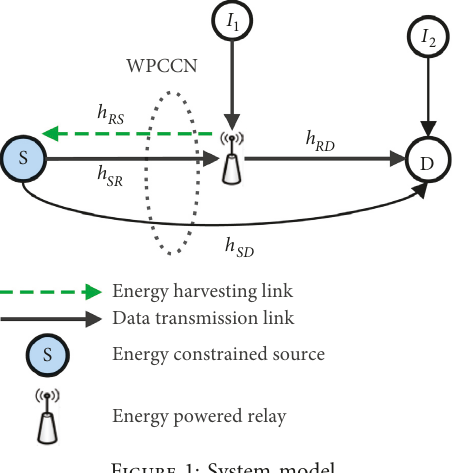
Figure 1: System model.